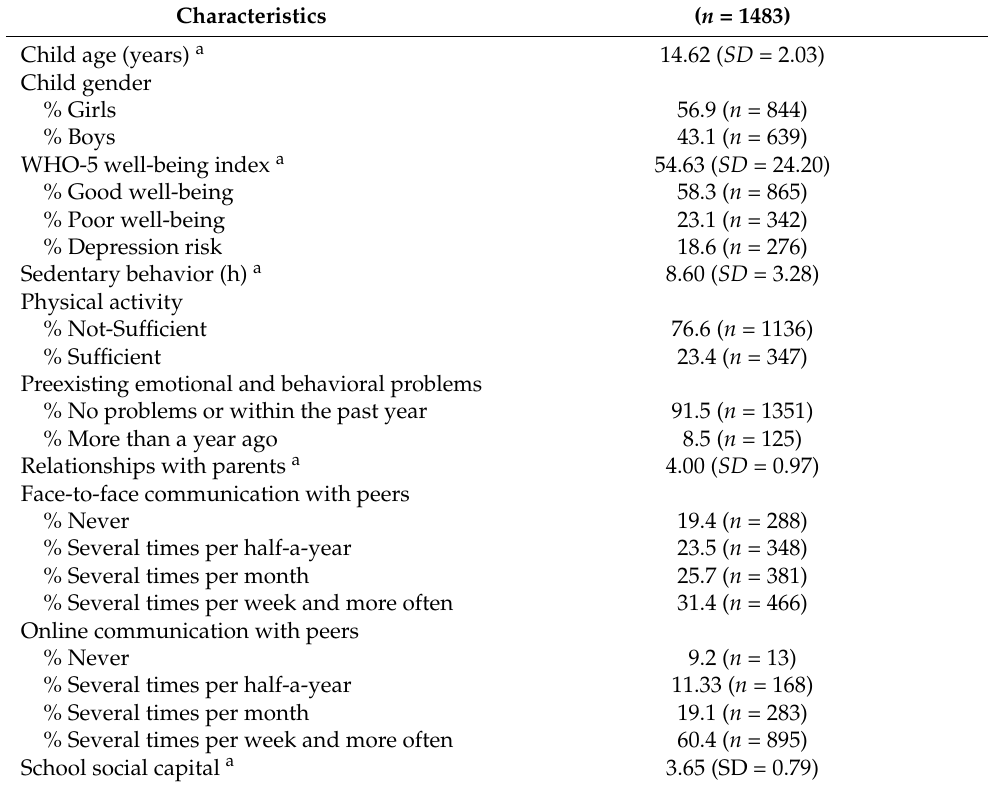
Table 1. Baseline characteristics of the